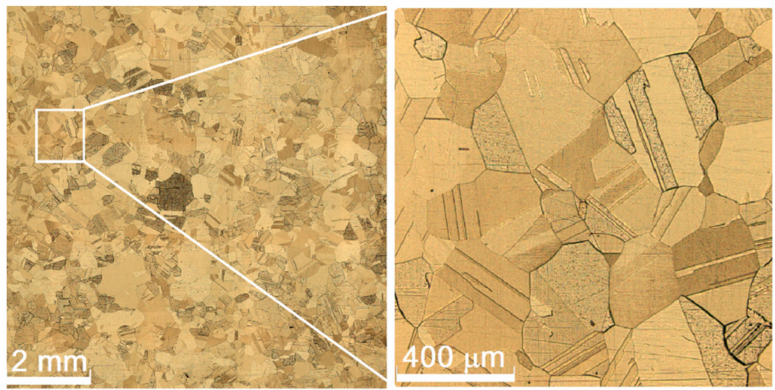
Figure 5. The microstructure of pre-deformed and annealed Cu-7.5wt.%Al bronze.